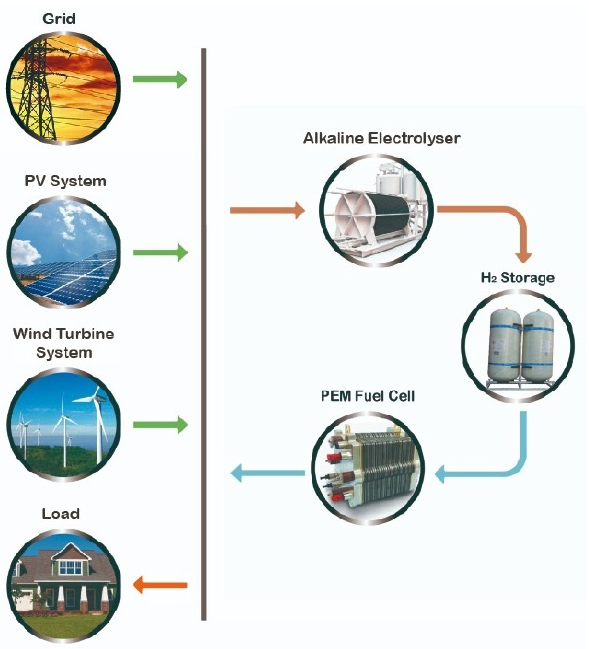
Figure 1. Schematic diagram of H µ